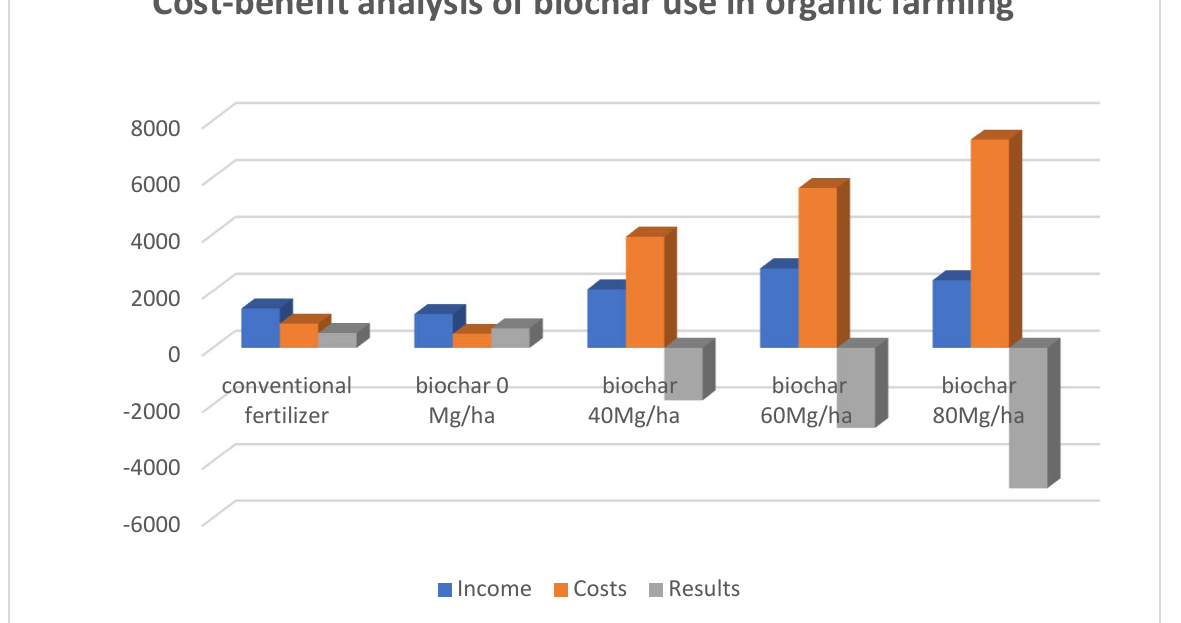
Figure 3. Comparison of the income and costs (in USD) of soybean cultivation using sunflower husk biochar (BA), left panel, and using wood chip biochar (BB), right panel.